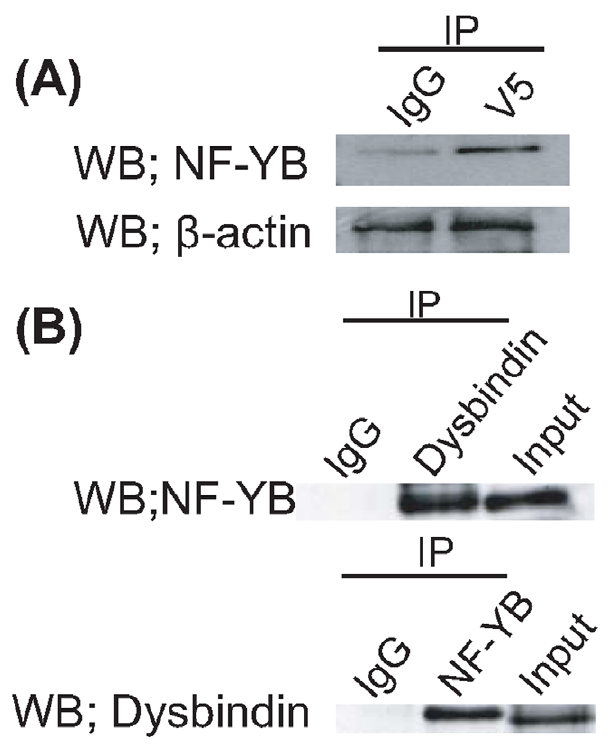
Figure 2. The interaction between Dysbindin and NF-YB. (A) HEK293 cells were transfected with Dysbindin-V5. Immunoprecipitates (IP) of lysates of HEK293 cells expressing Dysbindin-V5 obtained by antibodies to tag proteins (V5) (2 nd lane), or nonspecific rabbit IgG (IgG) (1 st lane) were subjected to Western blot with anti- NF-YB antibody (upper panel). Dilutions of the lysate (5%, HEK293 cells) were subjected to Western blot with anti- b -actin antibody (lower panel). ( B ) Immunoprecipitates (IP) of lysates of SH-SY5Y cells obtained by antibodies to Dysbindin (upper panel 2 nd lane), NF-YB (lower panel 2 nd lane), or nonspecific rabbit IgG (IgG) (1 st lane of both panels) were subjected to Western blot with anti- NF-YB antibody (upper panel) or Dysbindin antibody (lower panel). Dilutions of the lysate (5%, HEK293 cells) were subjected to Western blot with anti-NF-YB antibody (3 rd lane of upper panel) or Dysbindin antibody (3 rd lane of lower panel). Dysbindin knockout mouse brain [40]. The existence of endogenous Dysbindin and endogenous NF-YB in lysates from SH-SY5Y cells was confirmed by Western Blot (Figure 2B, 3 rd lane of both panels). Immunoprecipitation using the lysates with antibodies for Dysbindin and NF-YB and subsequent Western blot revealed the interaction of endogenous Dysbindin with endogenous NF-YB (Figure 2B, 2 nd lane of both panels), and this